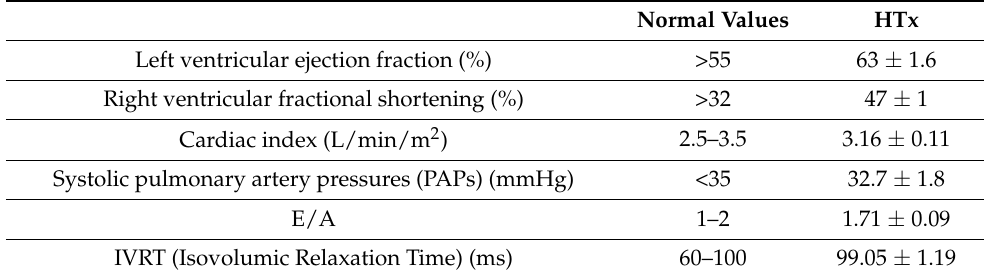
Table 3. Echocardiographic characteristics of